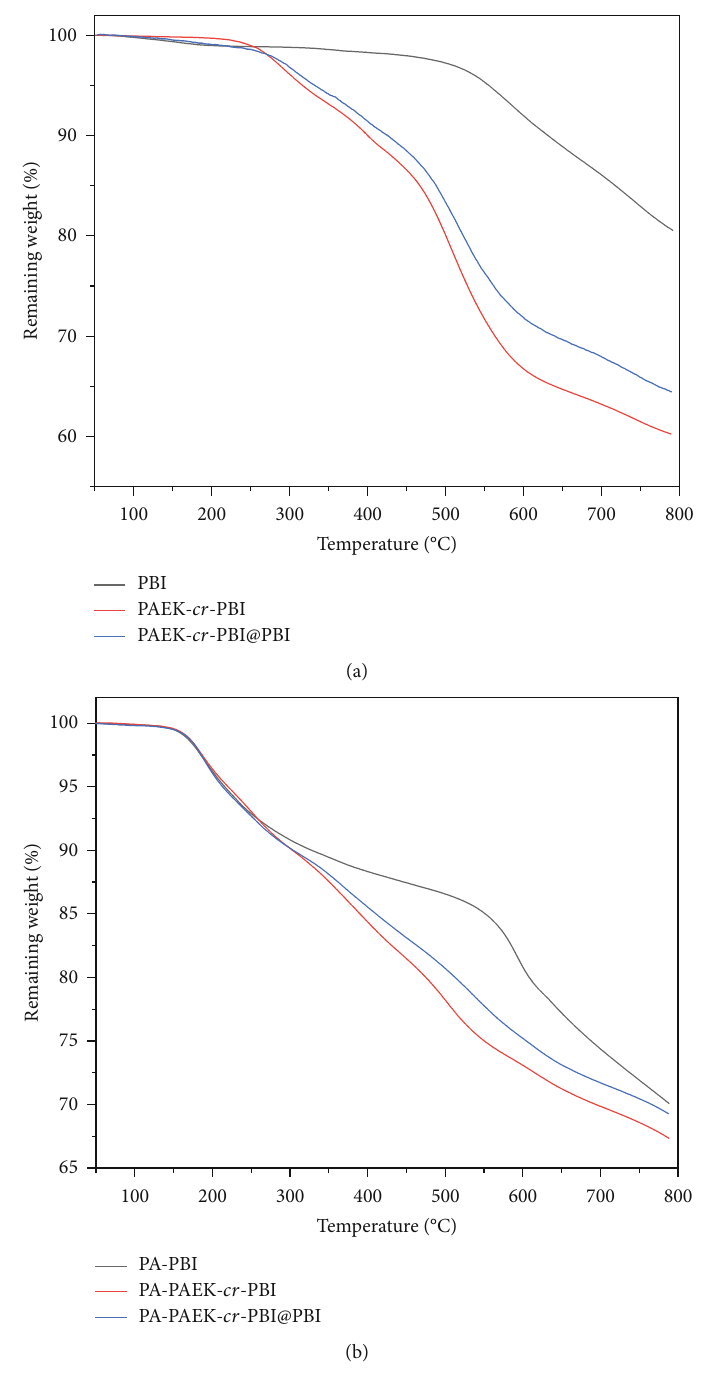
Figure 6: TGA curves of (a) PA-undoped and (b) PA-doped membranes under the N